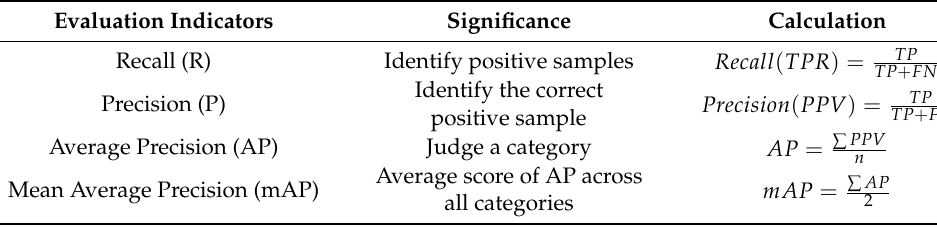
Table 2. The evaluation indicators of the model detection performance.